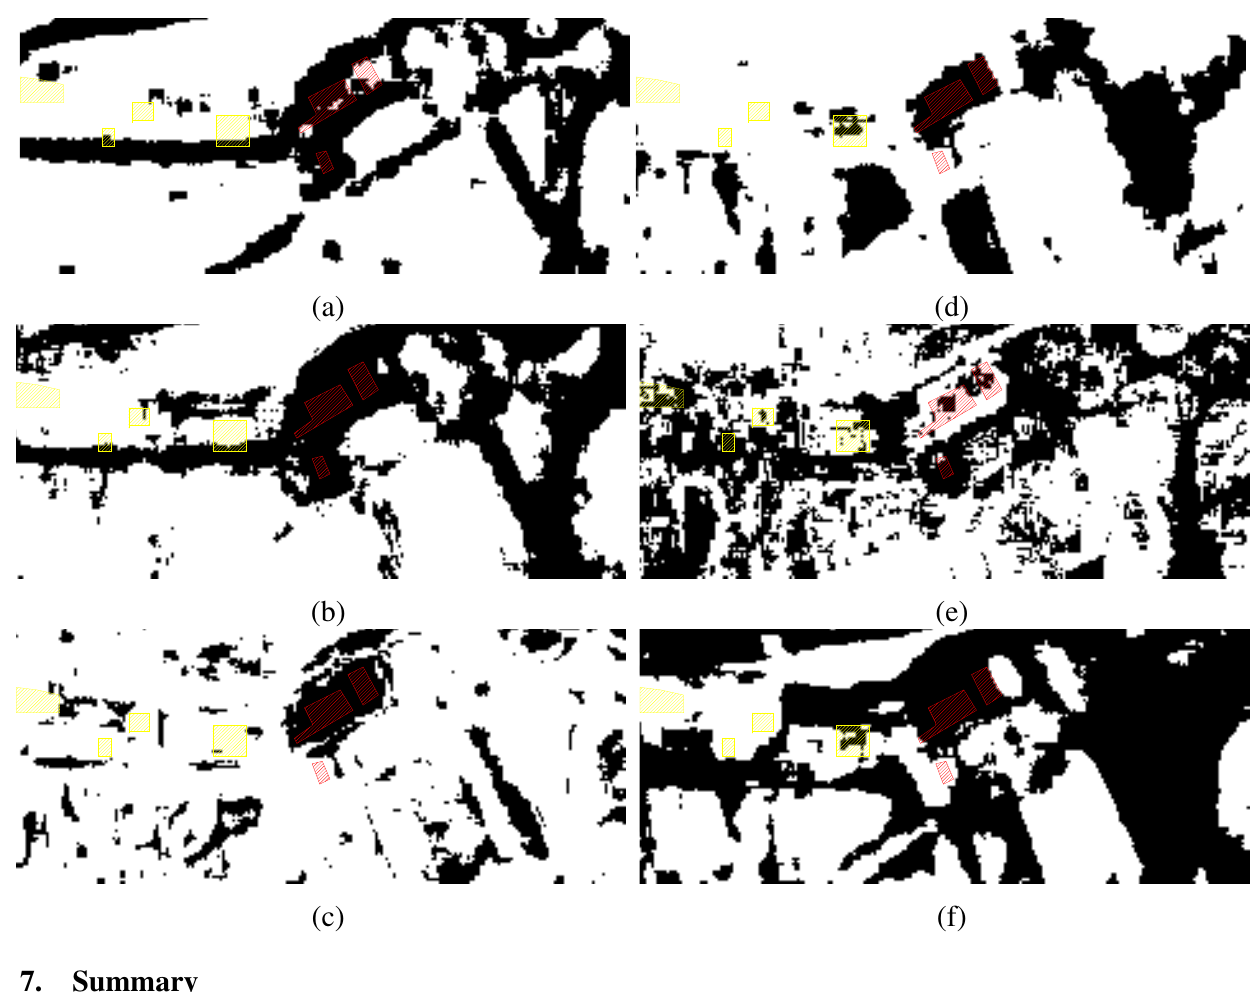
Figure 11. Panchromatic/HS pair, change/no-change maps based on manually selected sim- ilarity measure thresholds: (a) distance to independence; (b) mutual information; (c) CRA; (d) Woods criterion; (e) robust Woods criterion; (f) correlation ratio. In yellow and red, respectively, the ground truth areas corresponding to new and always present man-made ar-